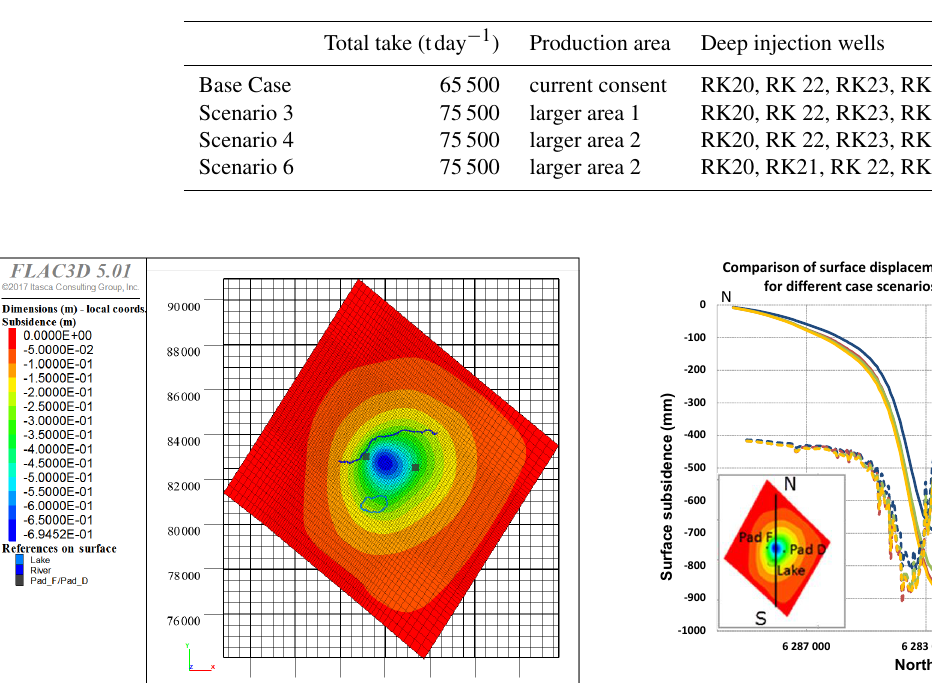
Figure 7. Future prediction of surface subsidence and tilt for all scenarios over period years